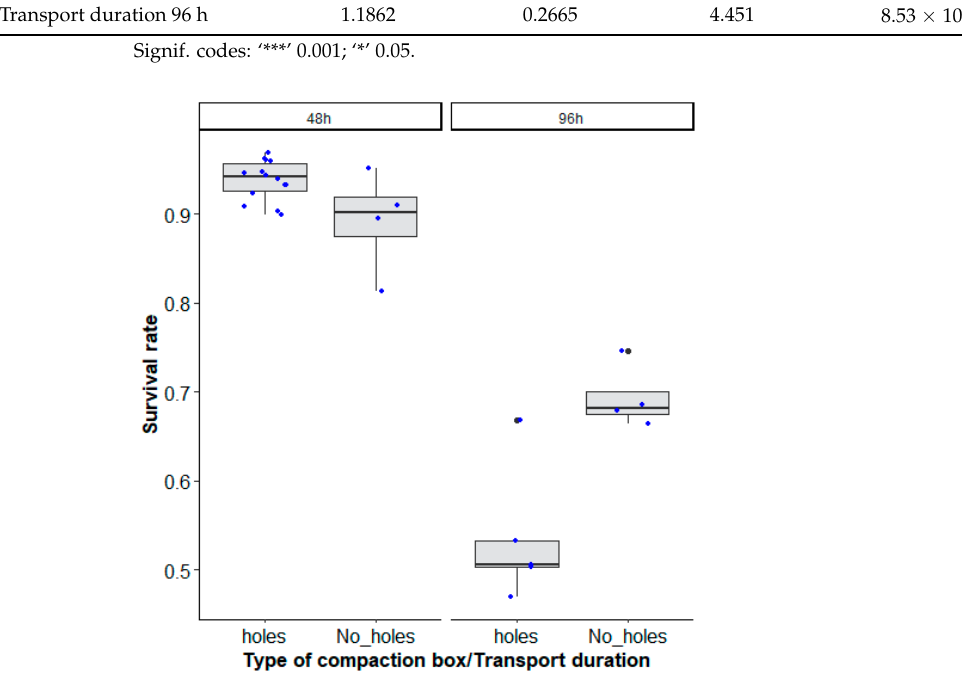
Figure 5. Aedes aegypti , Senegal strain, survival rates (recovery rates) according to the type of mosquito compaction square box with holes (‘holes’) and without holes (‘No_ holes’) and the duration of transport (48 h and 96 h). Black bars indicate the median. The upper and lower limits of each box indicate the interquartile range. Each blue dot represents a value of the observed escape rate per replicate. Black dots represent outliers.